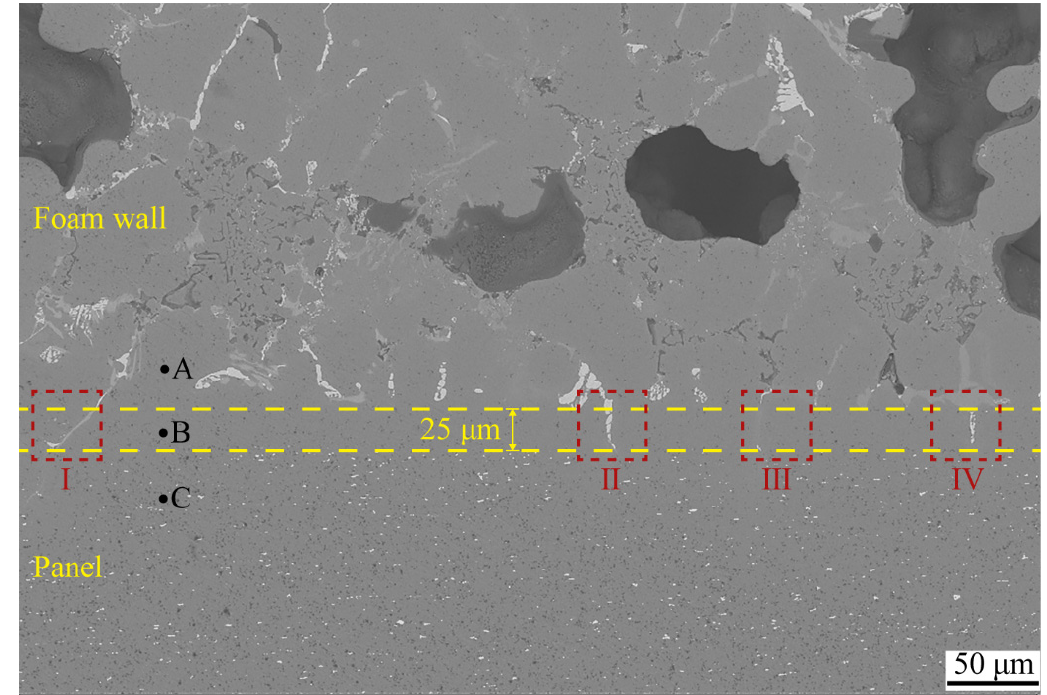
Figure 4. SEM micrograph of the core–panel interface.